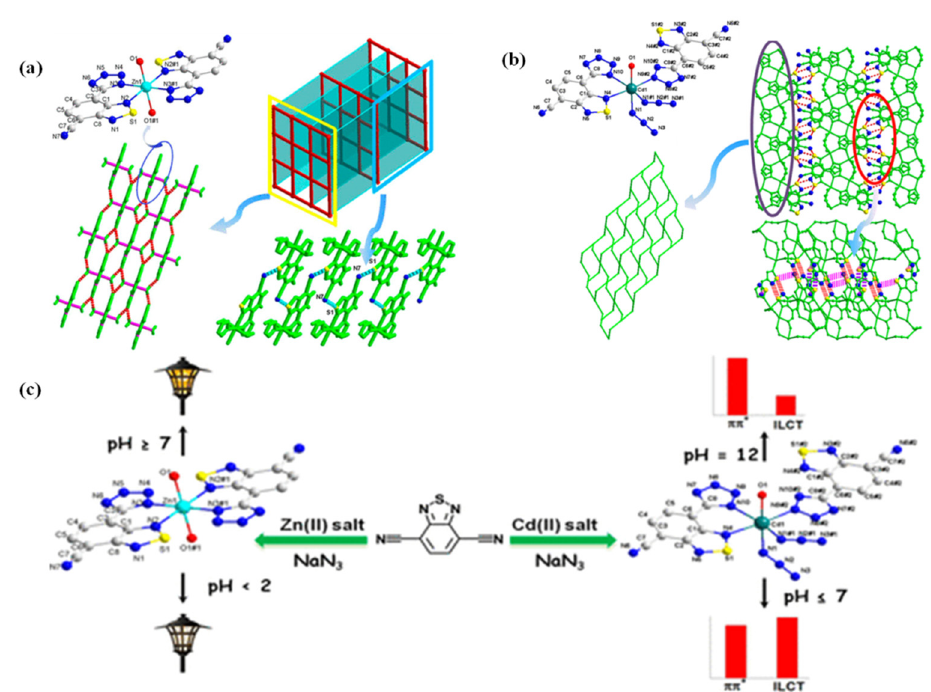
Figure 7. ( a ) Schematic illustration of Zn (II)-based MOF in monomeric structure and 3D supramolecular coordination with 4 4 -subnets by hydrogen bonding (2D 4 4 -subnet layer formed by hydrogen bonding, red dotted line) and interlayer N–S interactions (light blue dotted line) (all the hydrogen atoms are omitted for clarity). ( b ) Schematic illustration of Cd (II) coordination environment and its 3D supramolecular network as of the undulated 2D (8)(8 4 • 12 2 )-subnets by interlayer N–S interactions (red and magenta dotted line) (all the hydrogen atoms are omitted for clarity). ( c ) Illustration of pH responsiveness of Zn and Cd-based MOF. Reprinted with permission from Ref. [56]. Copyright 2018, American Society of Chemistry.